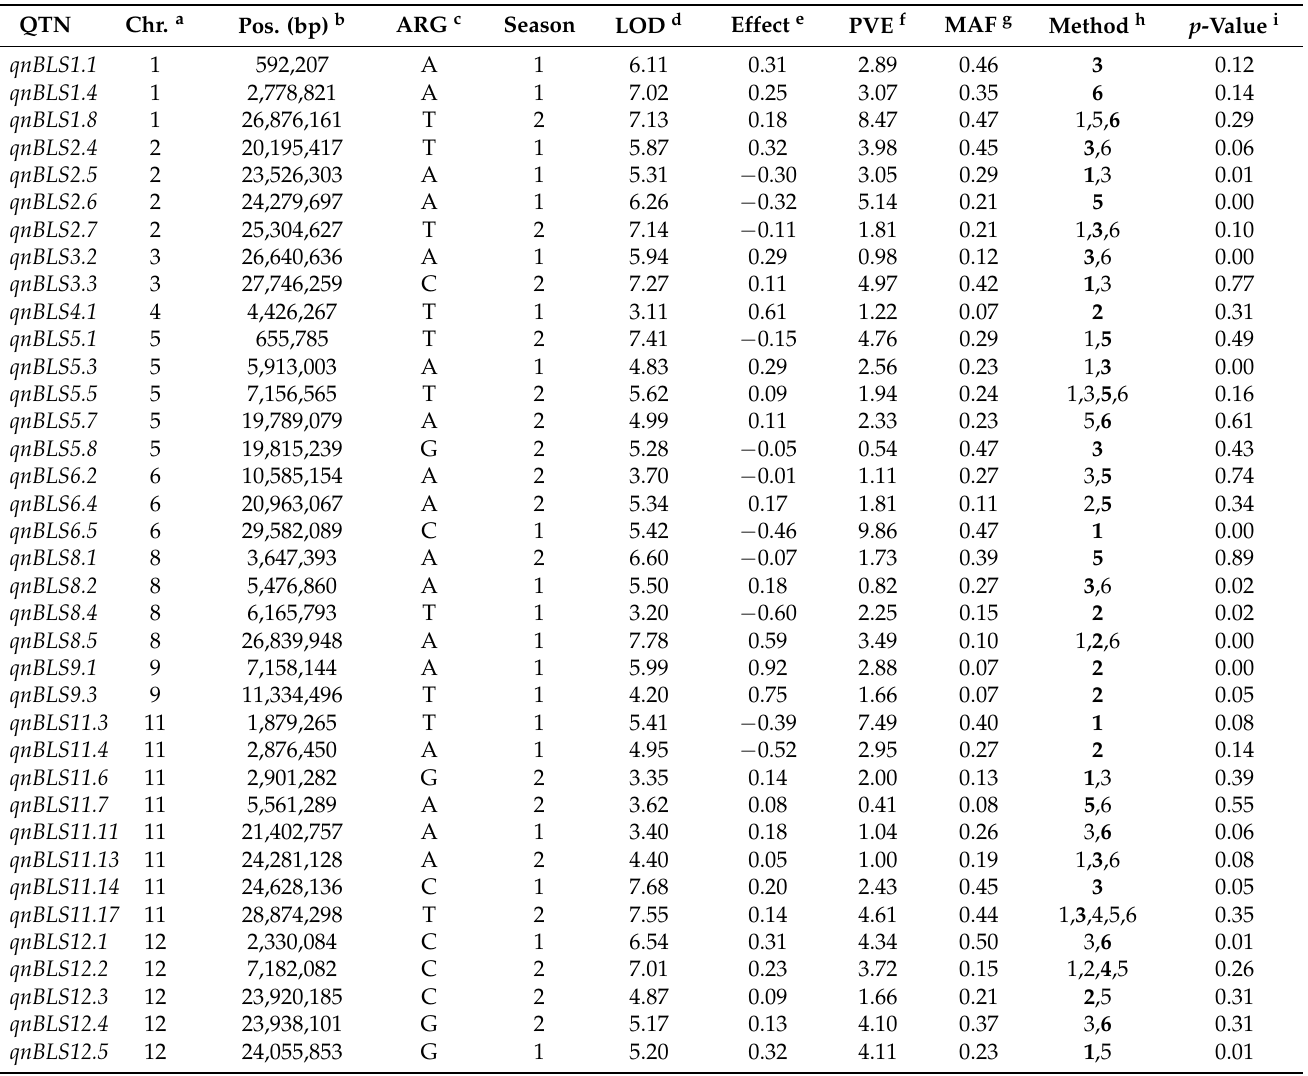
Table 2. Details of 37 important QTNs associated with BLS resistance in